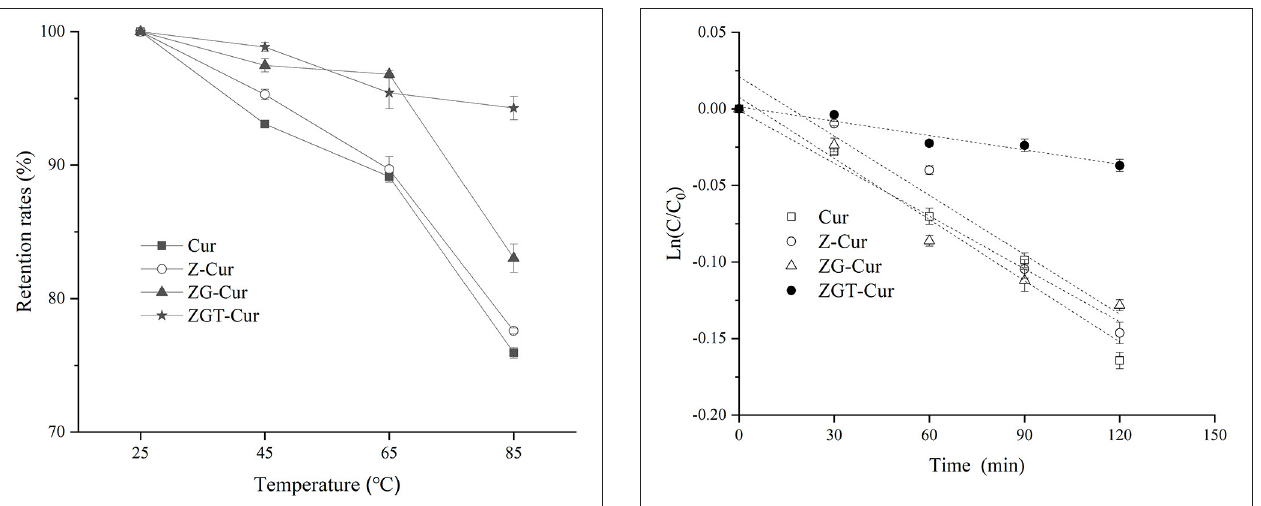
The coefficient of determination (R 2 ) of the fitting curve of each sample was > 0.95, and the degradation rate of Cur for each sample was between 0.00030 and 0.00118 min − 1 ( Table 1 ). The degradation rate of free Cur was 0.00118 min − 1 , and the